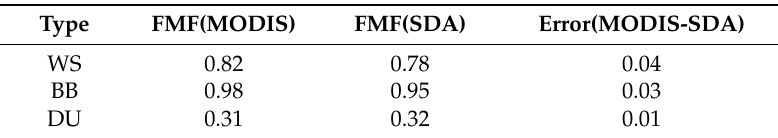
Table 2. The FMF differences between the Moderate Resolution Imaging Spectroradiometer (MODIS) algorithm and the spectral deconvolution algorithm (SDA) method in the WS, BB, and DU models.